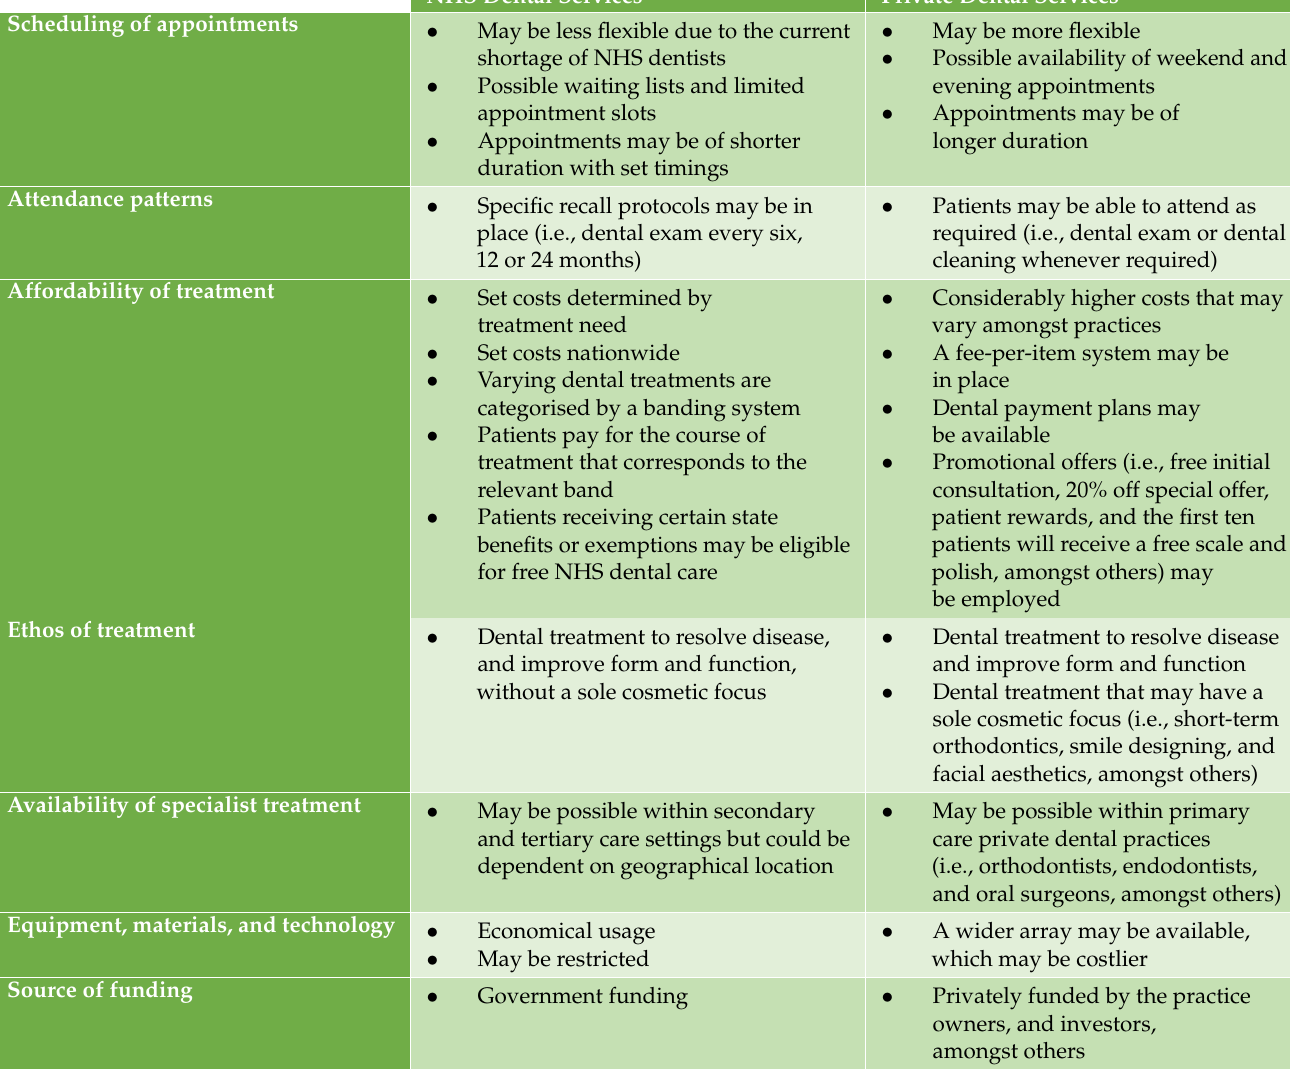
Table 1. Key differences between NHS and private